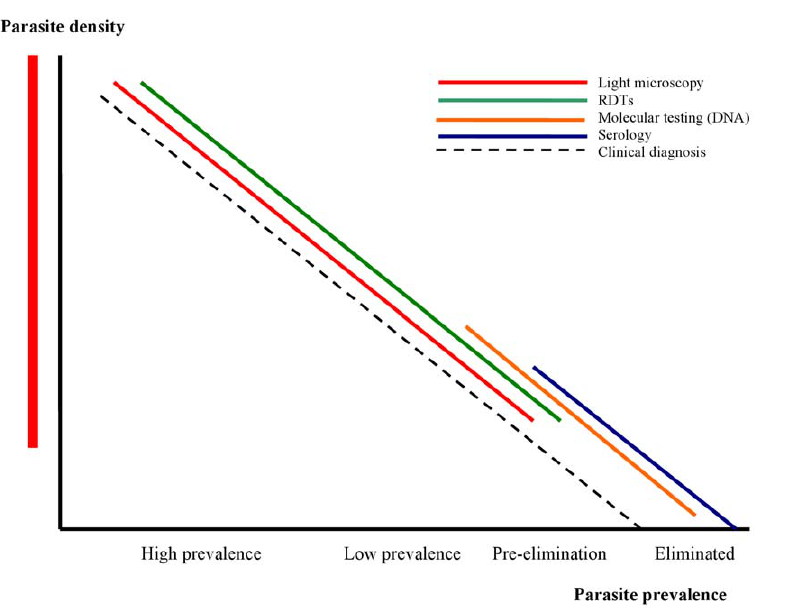
Figure 1. The position of different diagnostic approaches/tests in relation to morbidity, parasite prevalence, densities, and different stages towards malaria elimination. Image credit: Fusio´n Creativa.